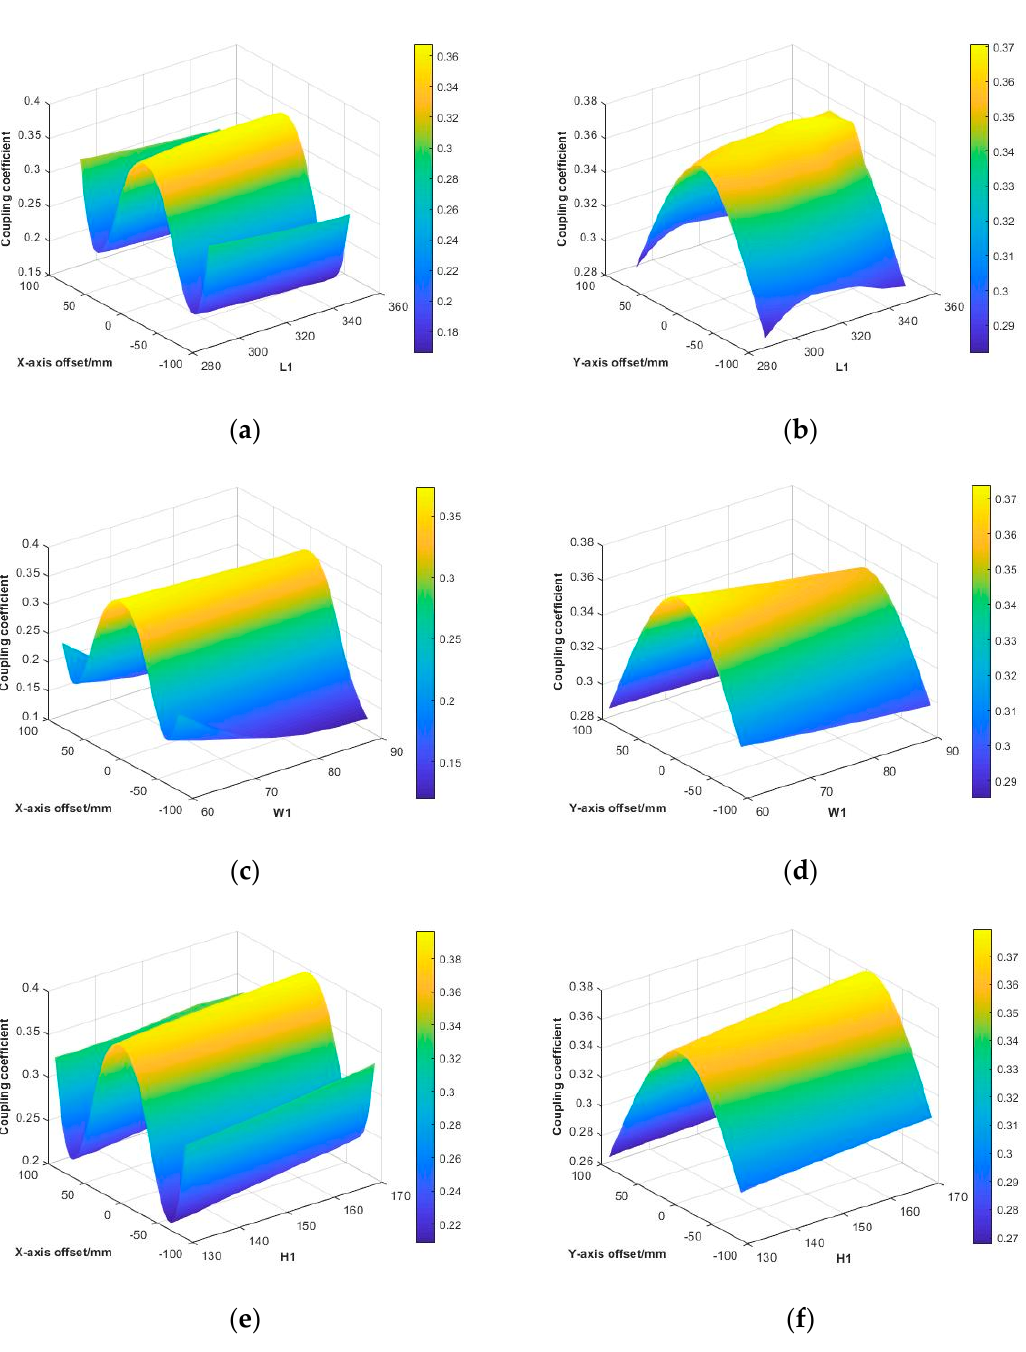
Figure 10. ( a ) Variation of coupling coefficients for different L1 lateral offsets. ( b ) Variation of coupling coefficients at different L1 longitudinal offsets. ( c ) Variation of coupling coefficients for different W1 lateral offsets. ( d ) Variation of coupling coefficients at different W1 longitudinal offsets. ( e ) Variation of coupling coefficients for different H1 lateral offsets. ( f ) Variation of coupling coefficients at different H1 longitudinal offsets.